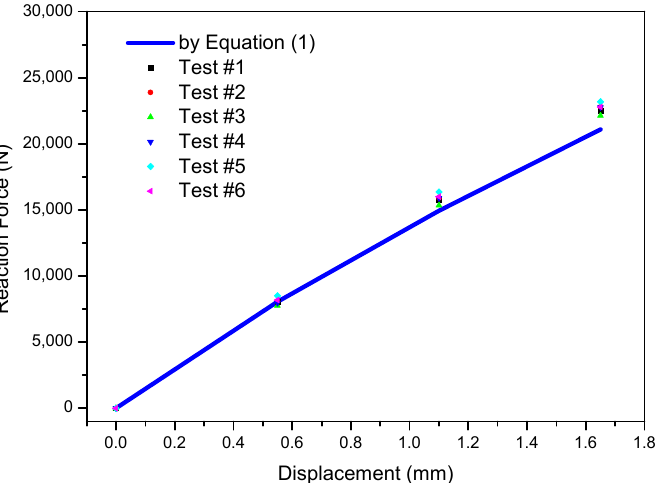
Figure 8. Comparison of the linearity characteristics between tests and calculation values by formula for a single disc spring.